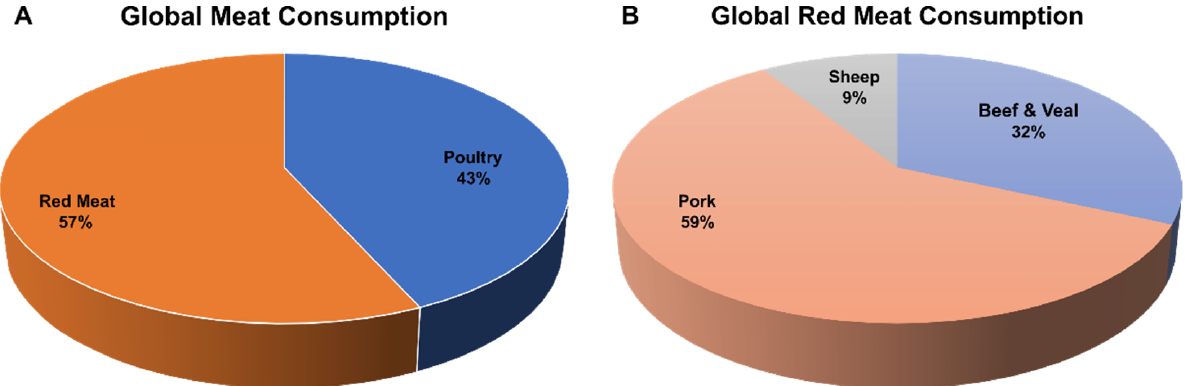
Figure 4. Global meat and red meat consumption. Percentages of ( A ) global meat and ( B ) red meat consumption in 2021, according to the OECD-FAO agricultural report of 2022 [17] .